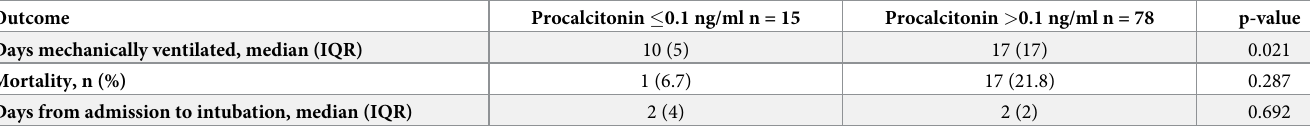
on admission were associated with prolonged mechanical ventilation in critically ill COVID- 19 patients. The multiple linear regression model revealed that the duration of mechanical ven- tilation was, on average, 5.6 days longer in patients with an initial procalcitonin level > 0.1 ng/ Table 2. Univariate analysis. Outcome Days mechanically ventilated, median (IQR) Days from admission to intubation, median